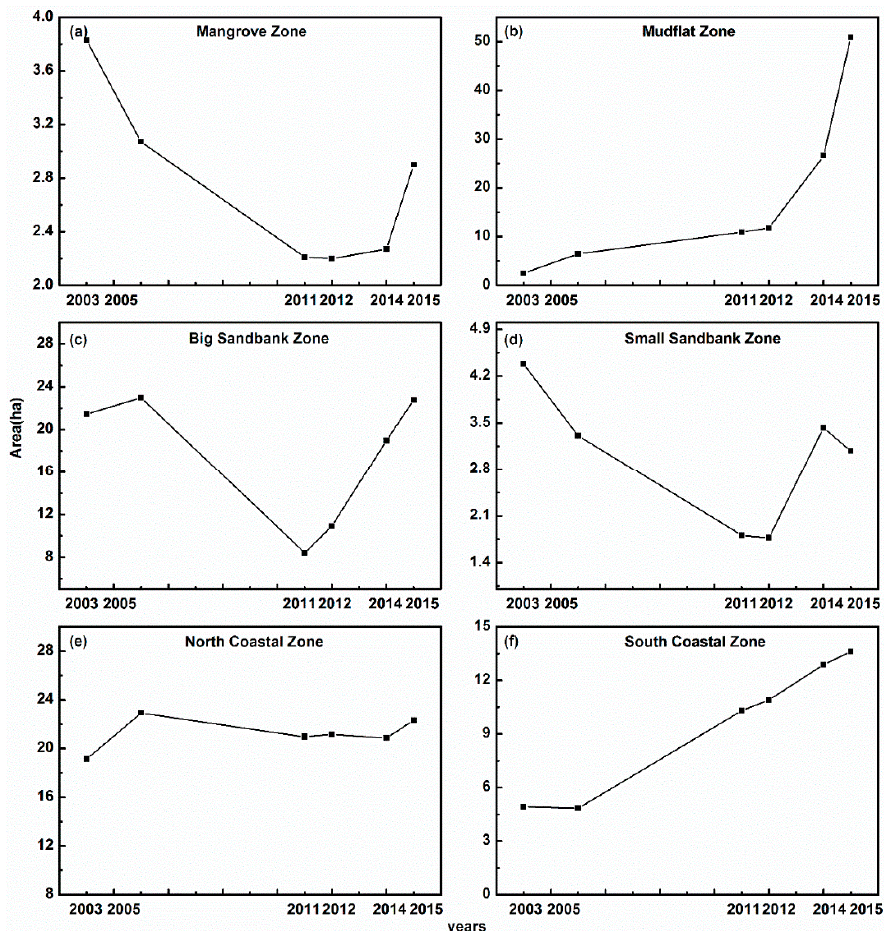
Figure 5. Expansion patterns of S. alterniflora in subzones during the study period.